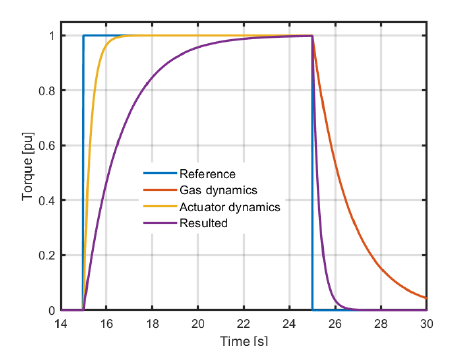
Figure 4: Step response of diesel engine The representation of diesel engine dynamics